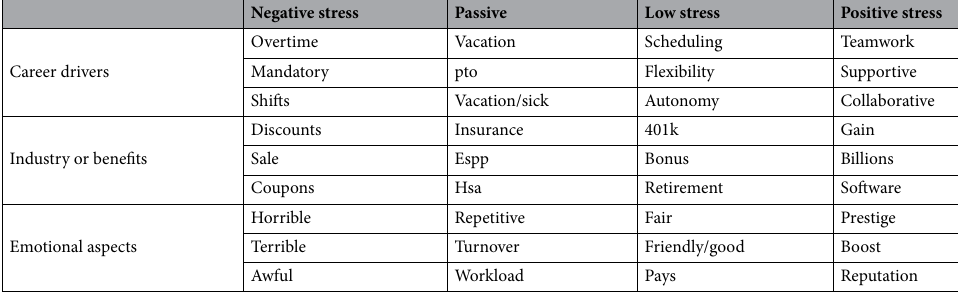
Table 3. Three-word groups present in the reviews of companies of the four stress types. These groups were automatically found by BERTopic and speak to three main workplace characteristics: career drivers, industry and benefits, and emotional aspects. For each group, the top three words are shown together with their normalized word importance. Abbreviations of words describing monetary benefits include pto (paid time off); espp (employee stock purchase plan); hsa (health savings account); 401 k (a retirement savings and investing plan that employers